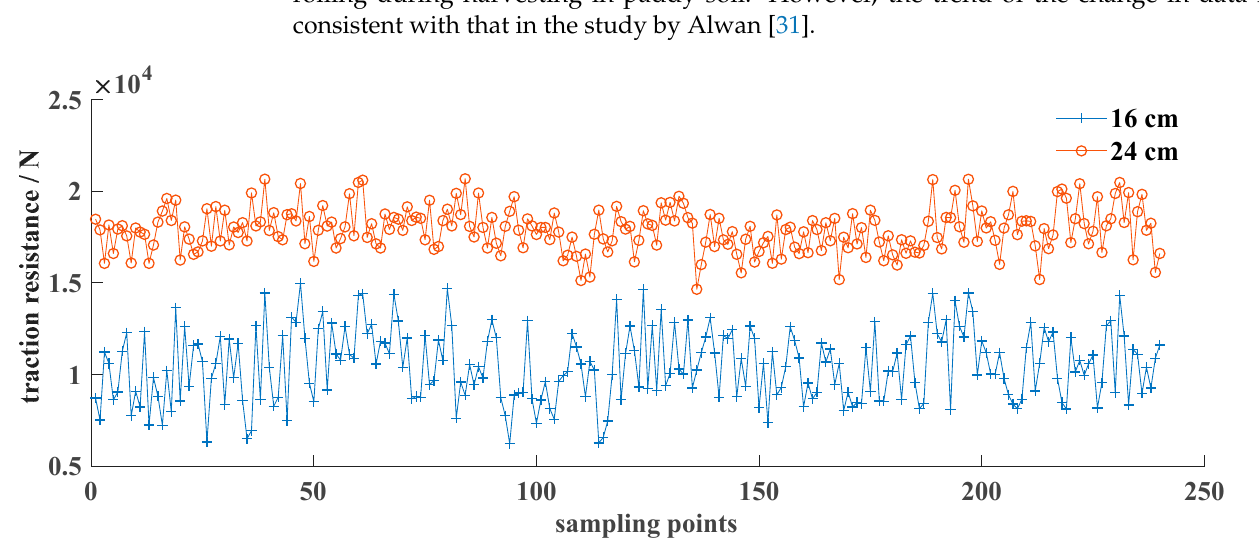
Figure 6. Traction resistance at tillage depths of 16 cm and 24 cm.